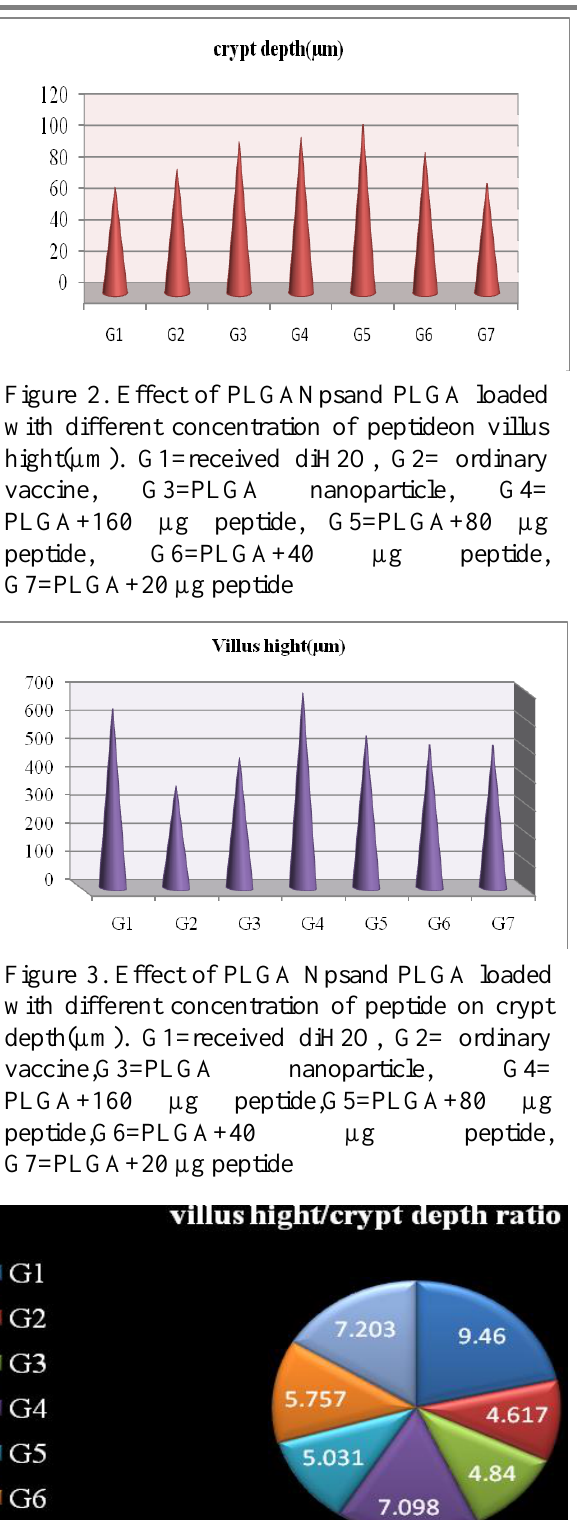
Figure 4. Effect of PLGA Npsand PLGA loaded with different concentration of peptide on villus hiegh/ crypt depth ratio. G1=received diH2O, G2= ordinary vaccine, G3=PLGA nanoparticle, G4= PLGA+160 µg peptide, G5=PLGA+80 µg peptide,G6=PLGA+40 µg peptide, G7=PLGA+20 µg peptide.